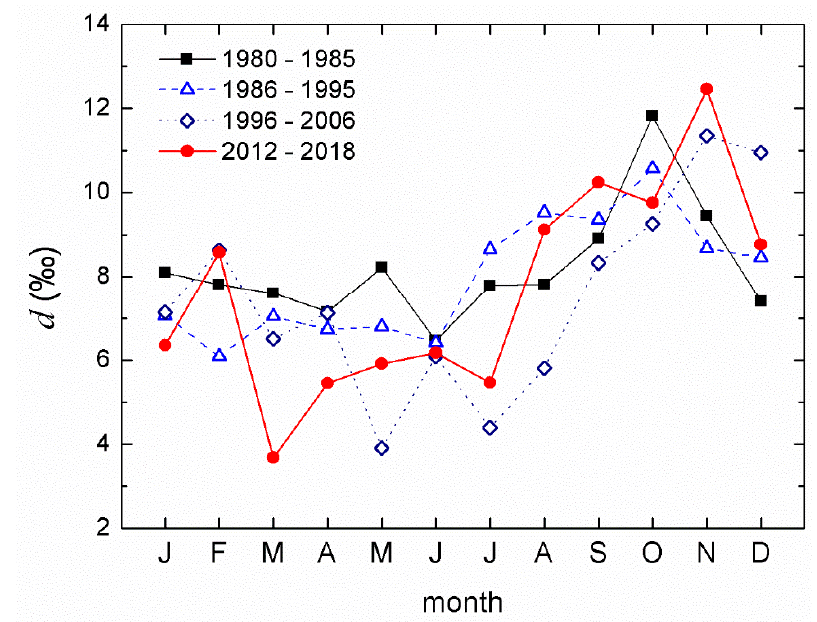
Figure 11. Monthly mean values of d -excess in the four subperiods.